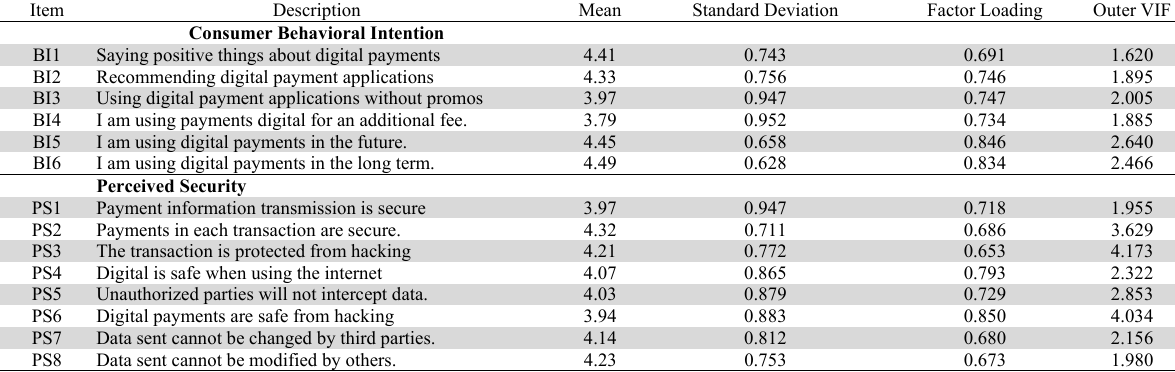
Mean, Standard deviation, factor loading, and outer